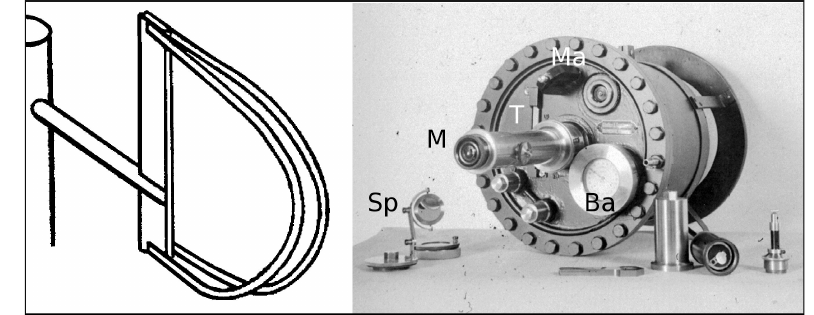
Figure 7. γ -ray electrometer after Kolh¨orster, manufactured by G&T until end of the 1940s. An important innovation was the use of u-shaped filaments (left). (Ma) is the magnet-operated device to connect the electrode to the filaments, (Ba) and (T) are a barometer and a thermometer, respectively. The movable mirror (Sp) could be attached to a window at the rear end in order to illuminate the inside.